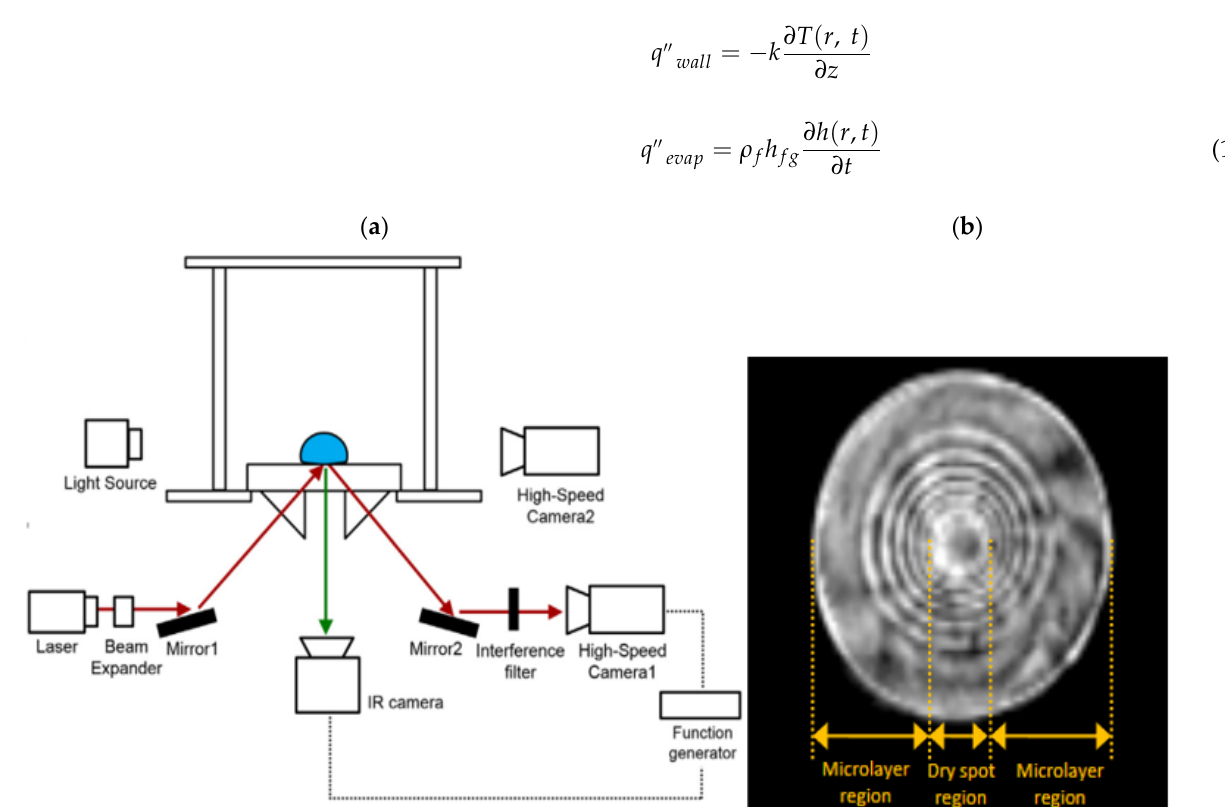
Figure 2. ( a ) Schematic diagram of the experimental setup; ( b ) Example image of interferometric pattern from bubble total reflection [33,34].